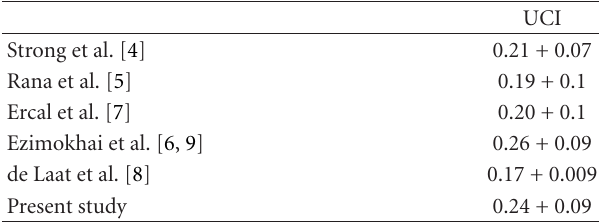
Table 6: Mean UCI in various studies.